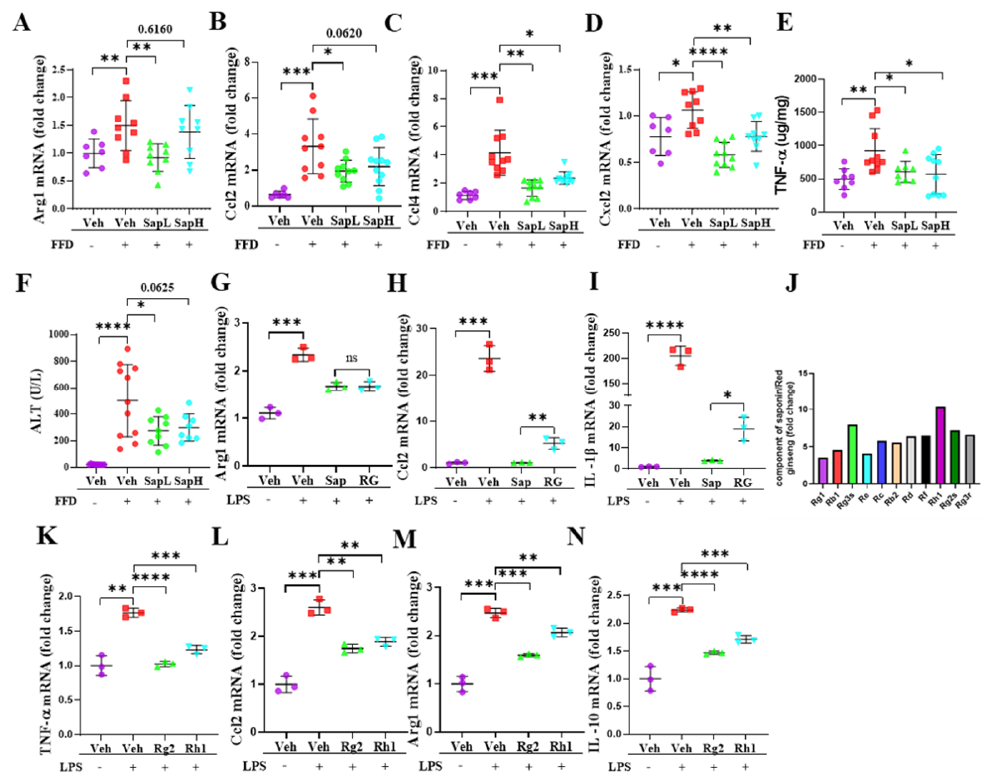
Figure 4. Saponin extract has high contents of ginsenoside Rh1 and Rg2 that exert an anti-inflammatory effect. The mRNA expression of inflammatory cytokines ( A ) Arg1, ( B ) Ccl2, ( C ) Ccl4, and ( D ) Cxcl2 were measured by qRT-PCR in the liver tissue. ( E ) The protein level of TNF- α in liver tissue lysates were determined by ELISA. ( F ) The level of ALT in the serum was measured. The mRNA expression of inflammatory cytokines in ImKCs, compared with saponin extract and red ginseng, ( G) Arg1, ( H ) Ccl2, and ( I ) IL-1β. ( J ) The fold changes of different compounds in saponin extract and red ginseng. The mRNA expression of inflammatory cytokines in ImKCs, compared with ginsenoside Rh1 and Rg2, ( K ) TNF-α, ( L ) Ccl2, ( M ) Arg1, and ( N ) IL-10. Relative mRNA expression levels were normalized to mouse GAPDH levels. The data are expressed as means ± sem. * p < 0.05, ** p < 0.01, *** p < 0.001, and **** p < Table 3. Contents of the eleven ginsenosides in red ginseng (RG) and saponin extract. Sample